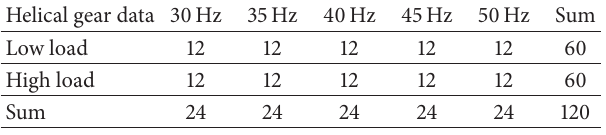
Figure 1: The whole processing of 1D LPB.